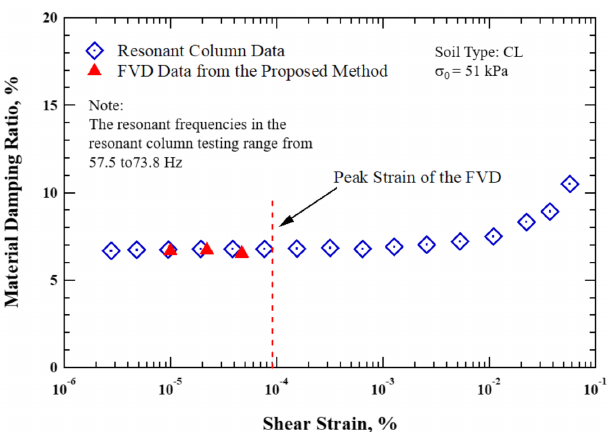
Figure 18. Viscous damping ratios from resonant column vs. free-vibration